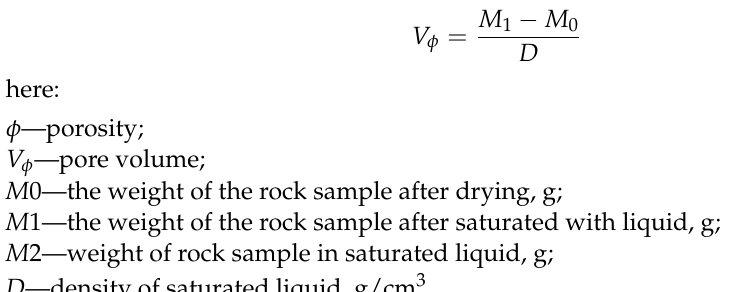
Through data processing, the correlation distribution between radial compression force and elastic index of the shale core was obtained, as shown in Figure 16. The core elastic index decreased with the increase in radial compression force, and the correlation between the elastic index and the radial compression force was 0.9861, which is a good correlation. It showed that with the increase in radial three-axis compressive force, the core